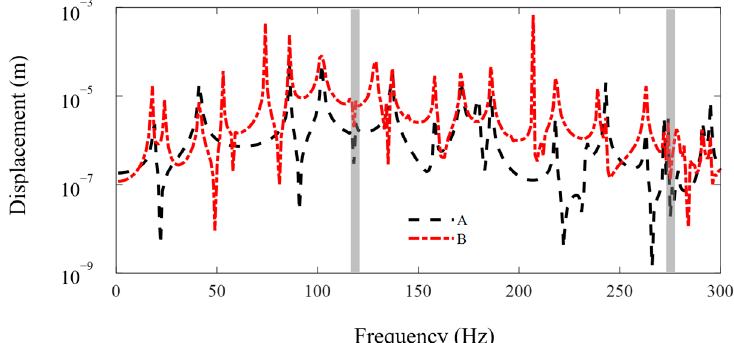
Figure 11. The FRF curves along the z axis at points A and B of the metamaterial plate. The dotted line and the dash-dotted line denote the FRF curves of point A and point B .